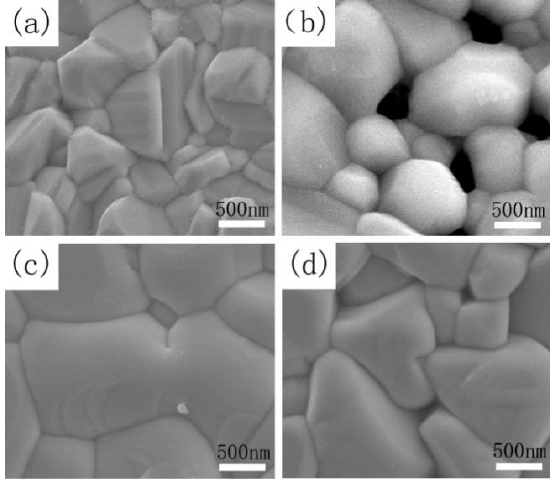
Figure 9. SEM images of CZTSSe annealed at 530 °C for ( a ) 15 min and CMZTSSe films annealed at 530 °C for ( b ) 10 min; ( c ) 15 min; and ( d ) 20 min.